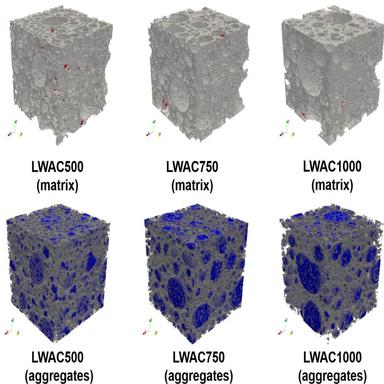
Pore structures of the LWAC specimens (Note: in each specimen, the top figures show the pores within the matrix (red), while the bottom figures show the pores inside the lightweight aggregates (blue).) (For interpretation of the references to colour in this figure legend, the reader is referred to the web version of this article.)